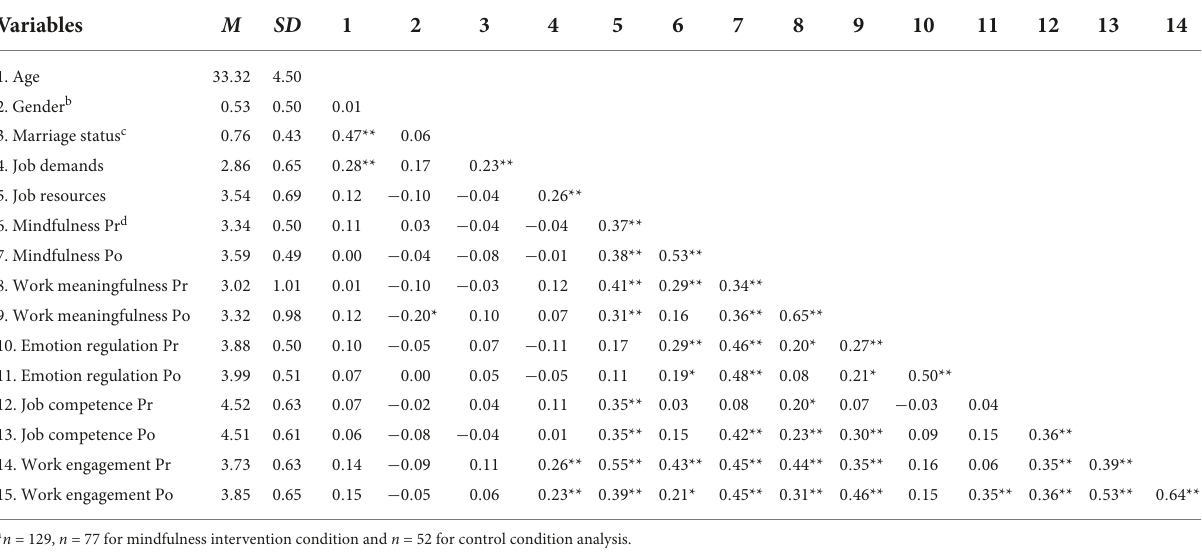
TABLE 1 Means, standard deviations, and correlations a .